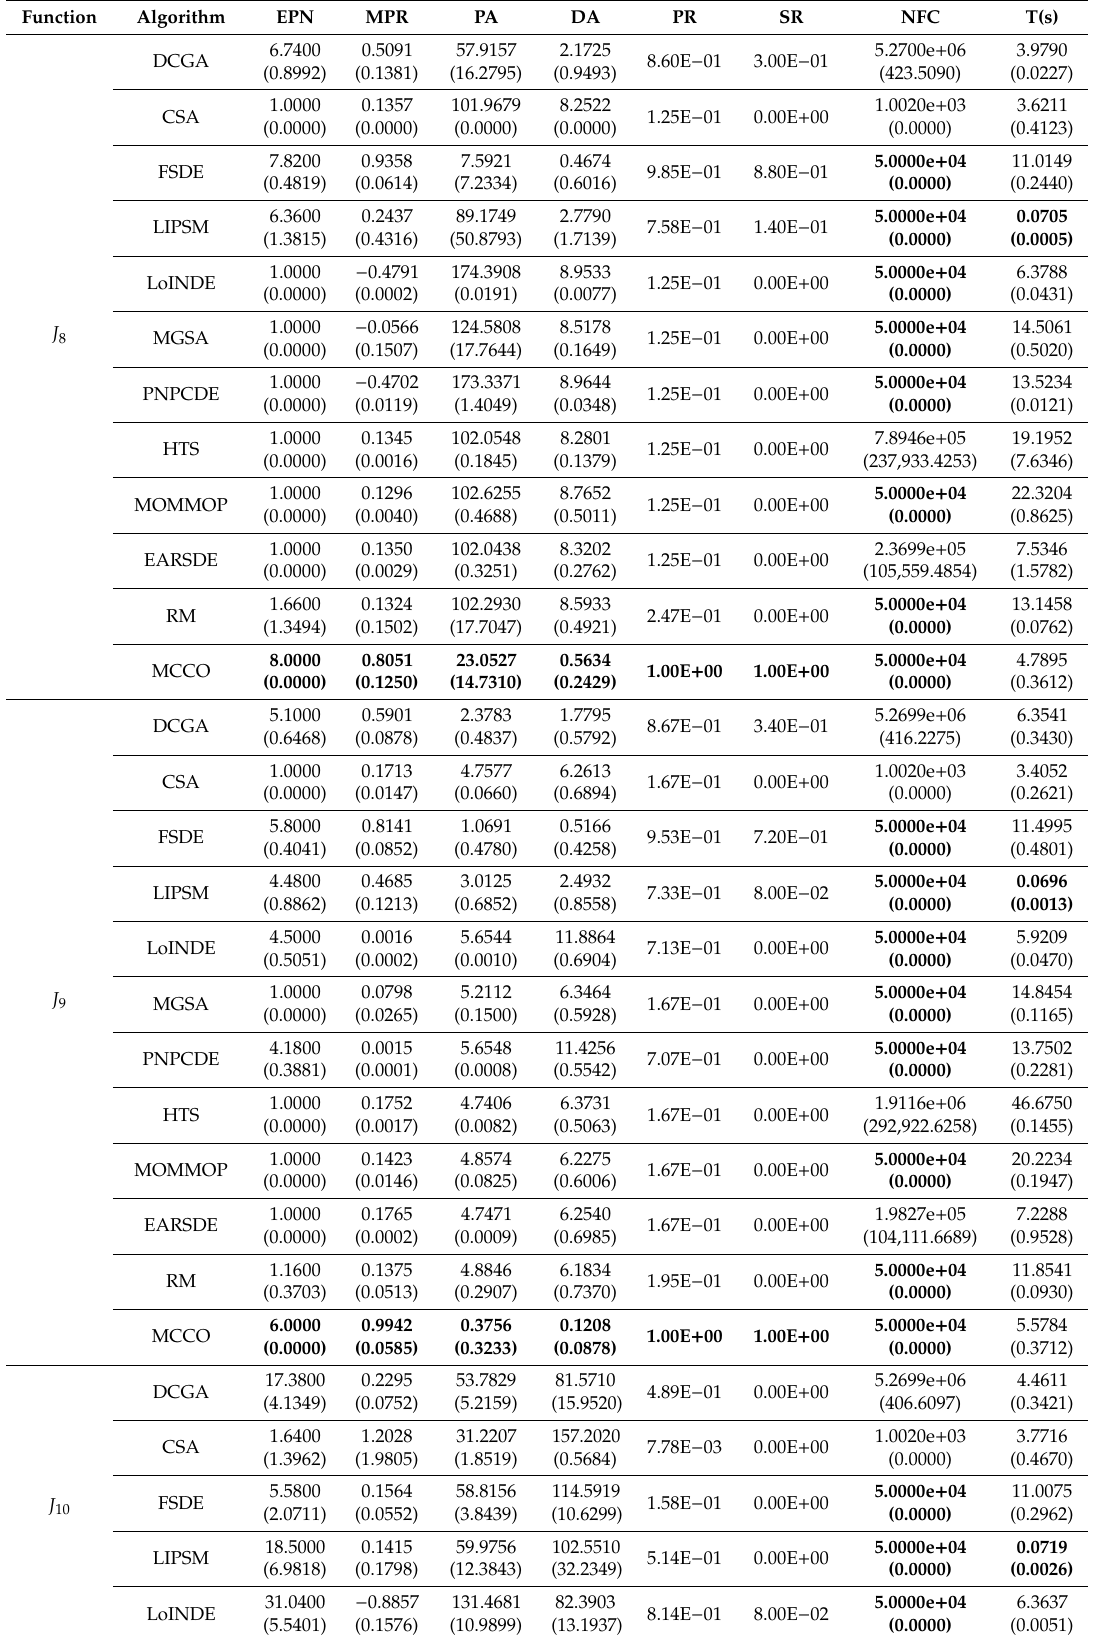
Table 4. Numerical results for J 8 – J 14 multimodal test